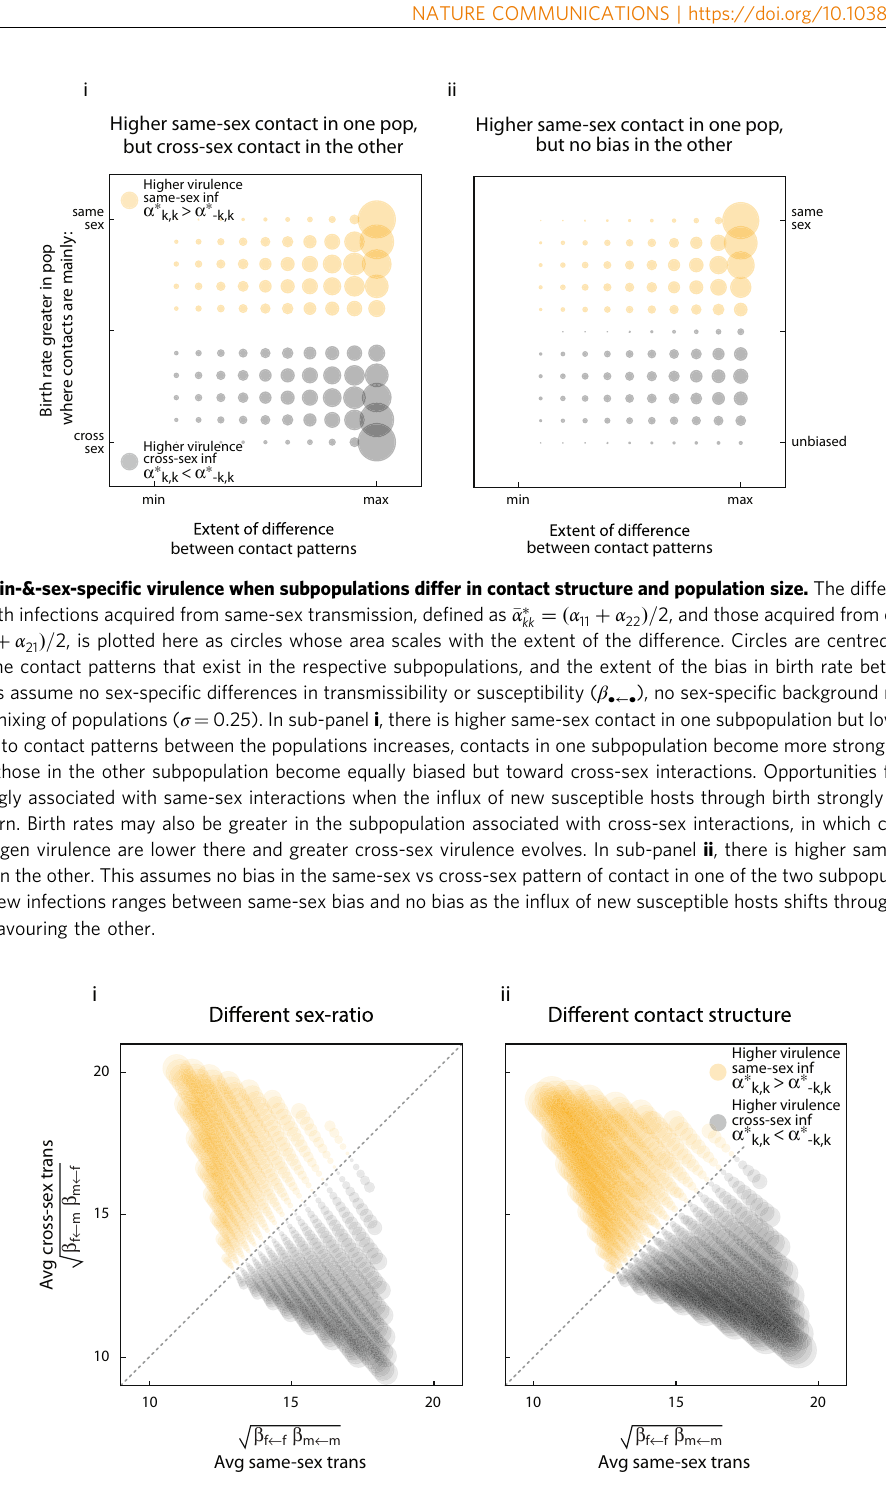
Fig. 7 Evolution of origin-&-sex-speci fi c virulence when subpopulations differ in same-sex and cross-sex transmission. The difference between average virulence associated with infections acquired from same-sex transmission and those acquired from cross-sex transmission are plotted as circles whose area scales with the extent of the difference itself. Circles are centred according to average same-sex transmissibility and average cross-sex transmissibility. We assume no sex-speci fi c differences in background mortality, no possibility of recovery, and weak mixing of populations ( σ = 0.1). In sub-panel i , the subpopulations differ in their sex-ratio such that the in fl ux of sexes to each subpopulation is biased in exactly opposite directions, but contact structure does not differ between populations ( c A i $ j ¼ c B i $ j ¼ 1). In sub-panel ii , the subpopulations differ in their contact structure. In fl ux of sexes to each population is unbiased, but same-sex contact is more common in subpopulation A ( c A j $ j > c A : j $ j ), while cross-sex contact is more common in subpopulation B ( c B j $ j < c B : j $ j